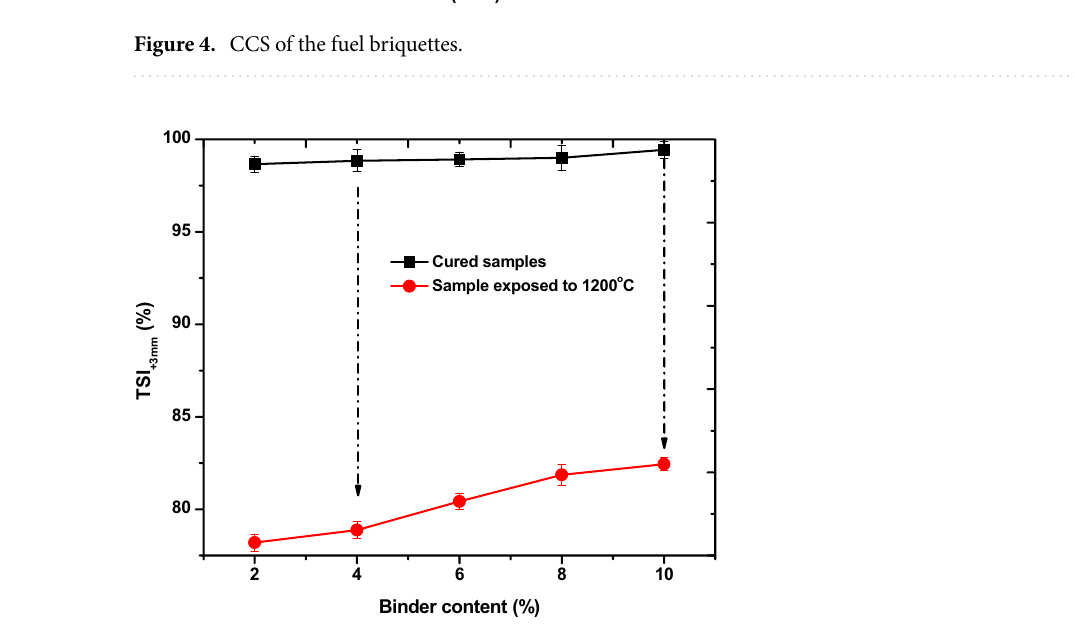
Figure 5. Tumbling strength index of the produced fuel